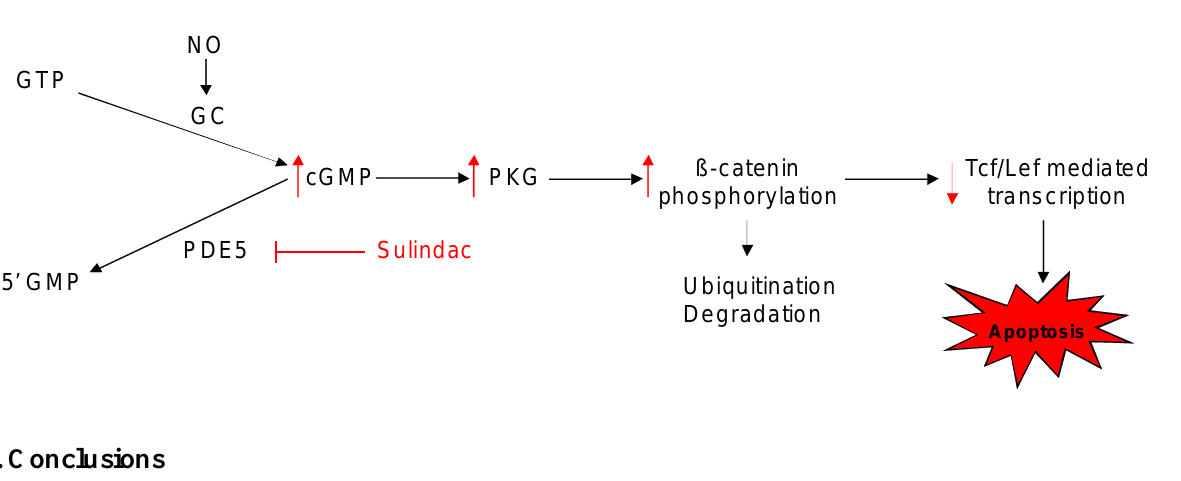
Figure 6. Mechanistic model for the apoptosis inducing properties of